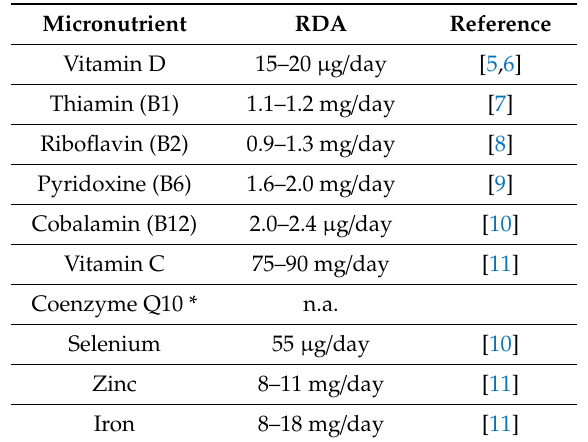
Table 1. Recommended micronutrient dietary allowance for the general